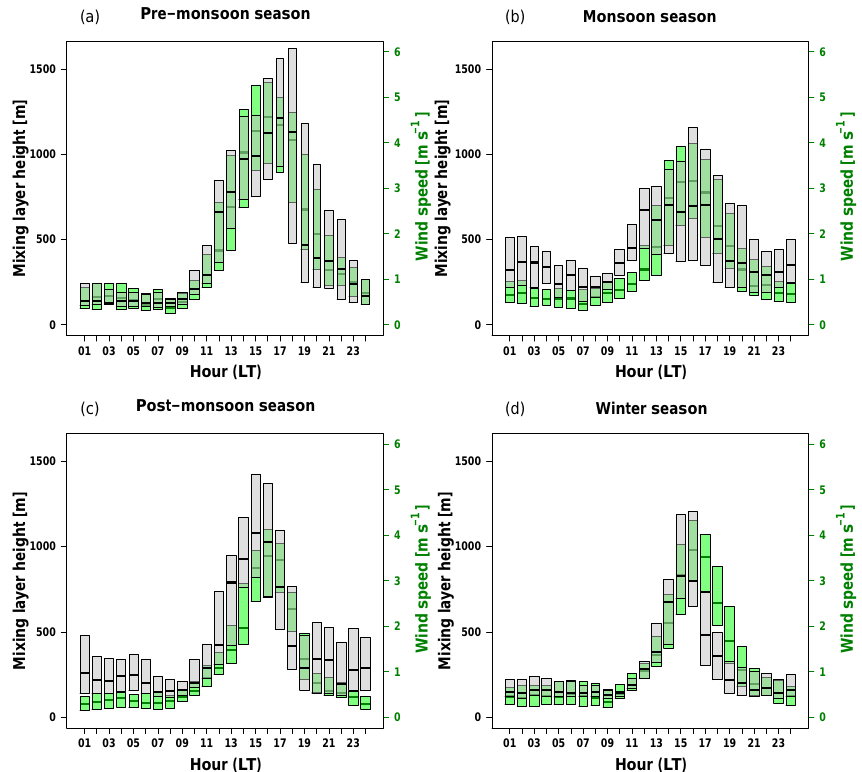
Figure 5. Mean diurnal cycle of the MLH (grey) and wind speed (green) as a boxplot (showing the median, the upper and lower quantile) for (a) the pre-monsoon (March–May 2013), (b) the monsoon (June–September 2013), (c) the post-monsoon (October–November 2013) and (d) the winter (December 2013–February 2014) season at the Bode station.